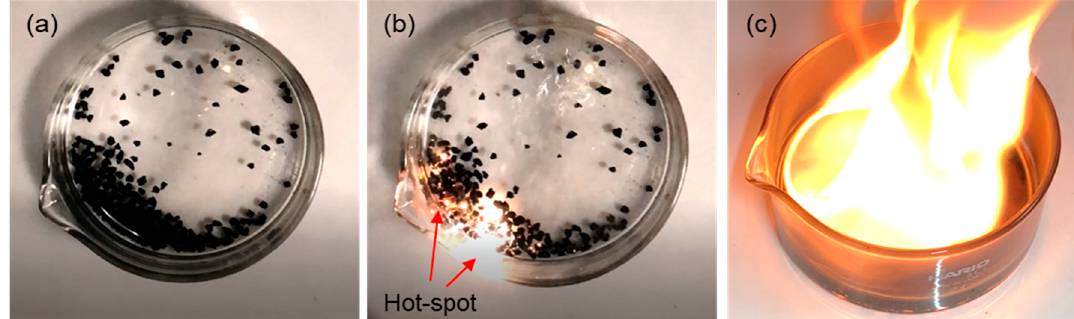
Figure 7. Photographs of the ignition of toluene associated with microwave irradiation in a dispersion of activated carbon particles (diameter, 0.65 to 1.10 mm): ( a ) No microwave irradiation; ( b ) appearance of a discharge (hot spot) with the multimode applicator type VFM chemical equipment after irradiation with FFM microwaves (5.85 GHz; 350 W) for 30 s; ( c ) fire that occurred 49 s later.